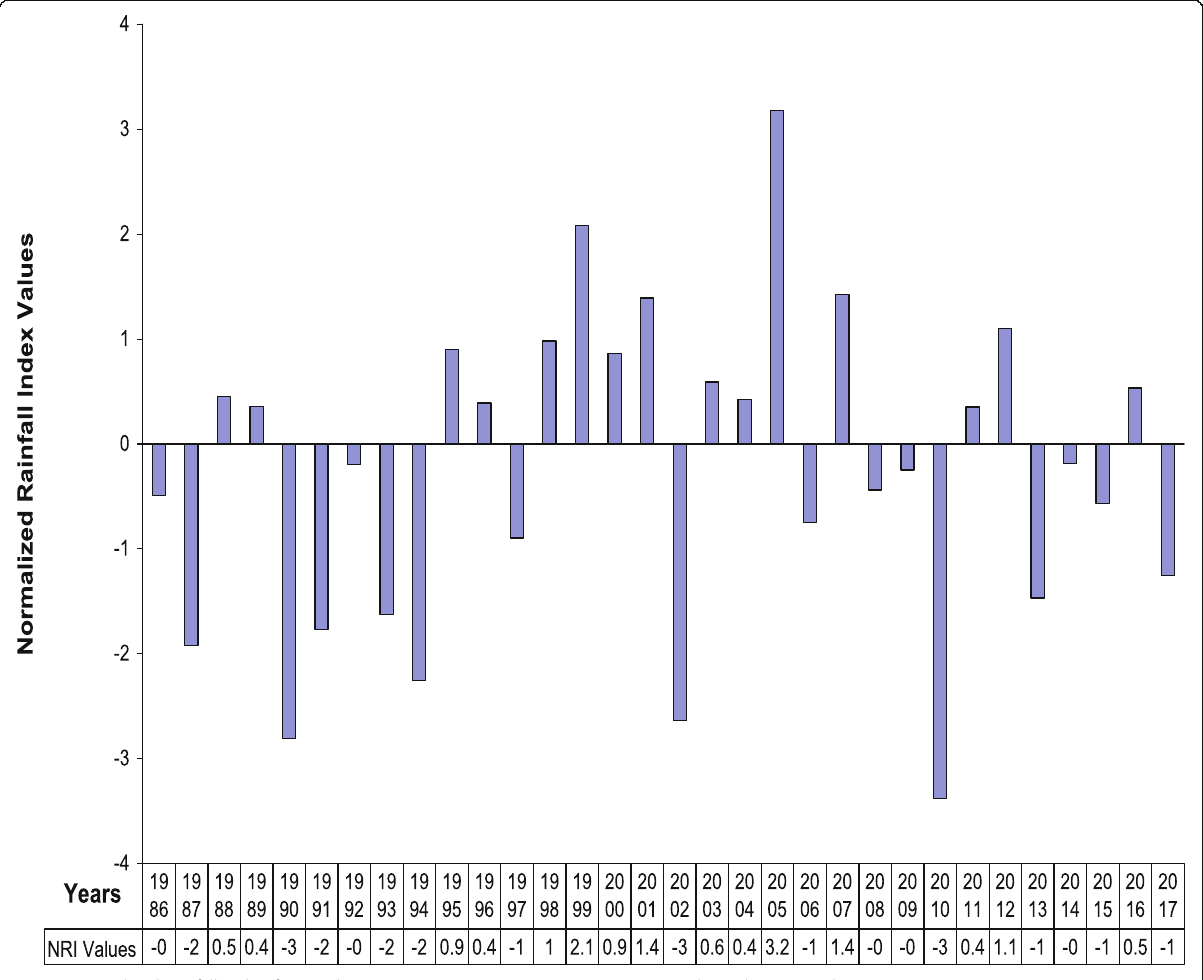
Fig. 1 Normalized rainfall index for Maiduguri station (Data source: Nigerian Meteorological Agency Abuja